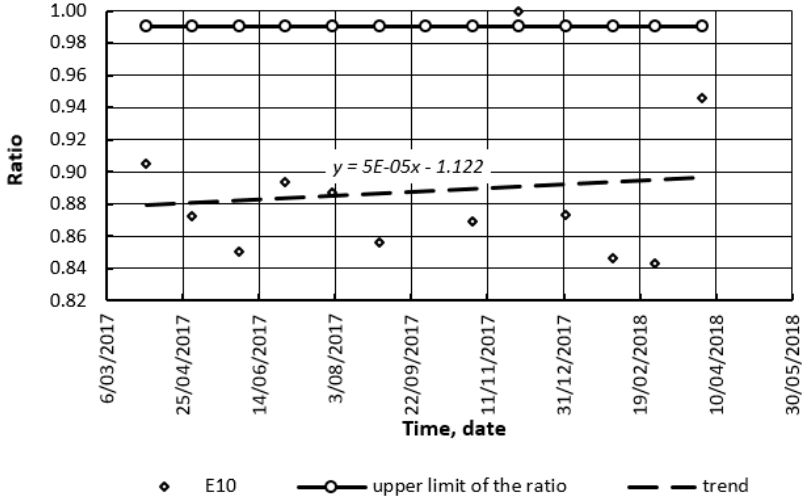
Figure 12. E10 / gasoline prices ratio in the USA [49].